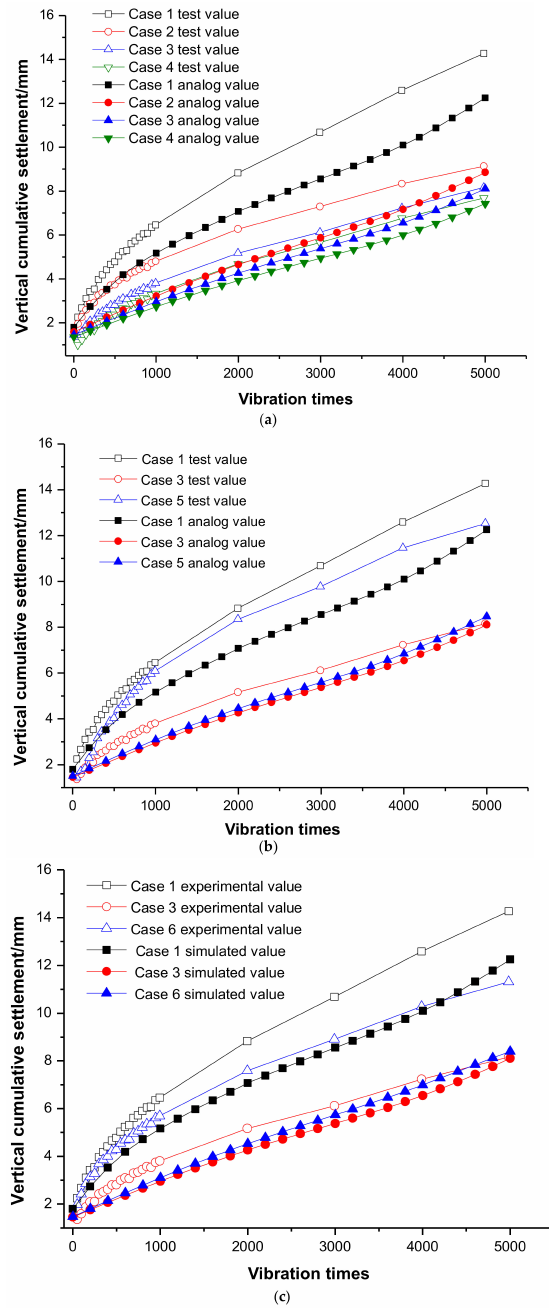
Figure 7. Settlement changing with vibration times under cyclic loading under different